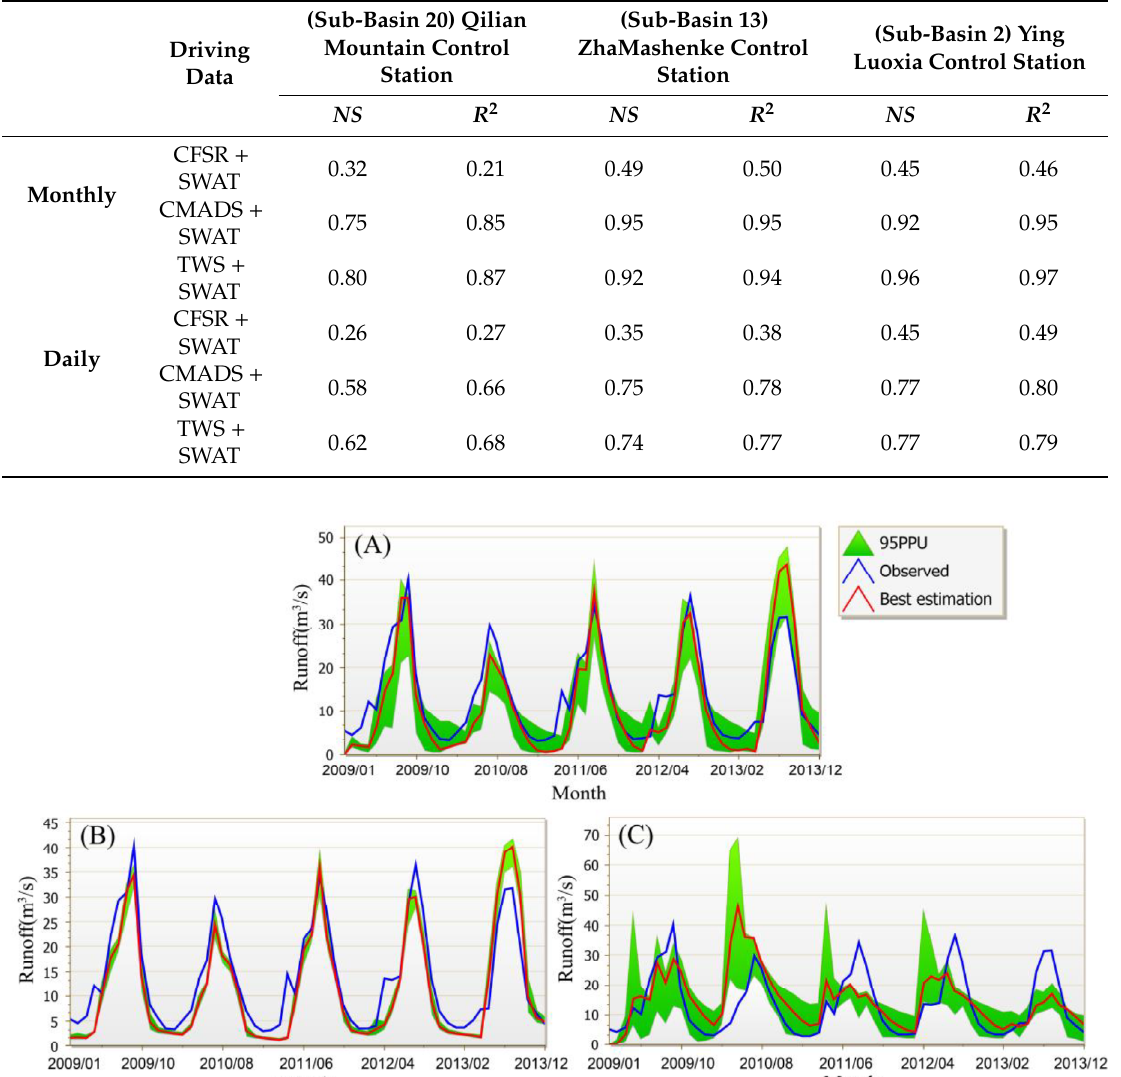
Table 5. Evaluation of monthly and daily matching results at three stations driven by three di ff erent modes.